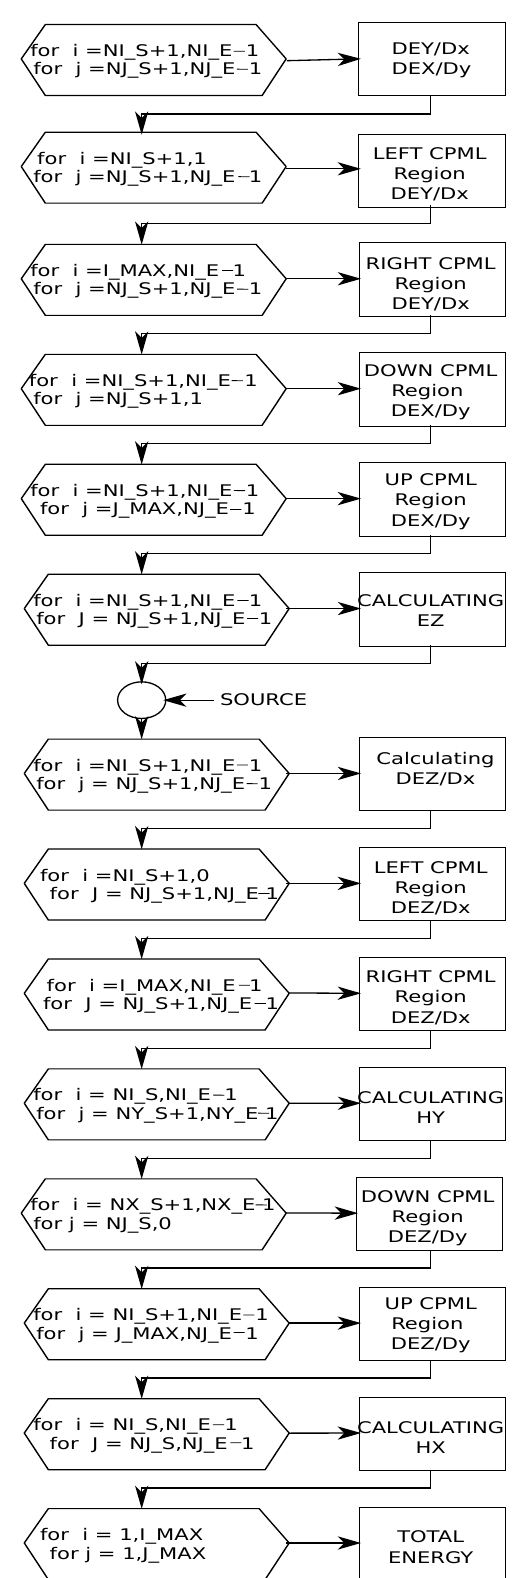
Figure 4. Flux diagram showing the fourteen cycles necessary when the convolutional variables are allocated only in the absorption region. Saving Memory but increasing the number of cycles. The cycles are numbered as M 1 · · · M 14